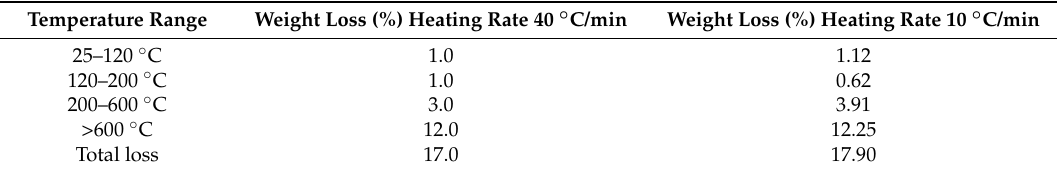
Table 6. Loss of mass of sample S-004 as a function of temperature variation.